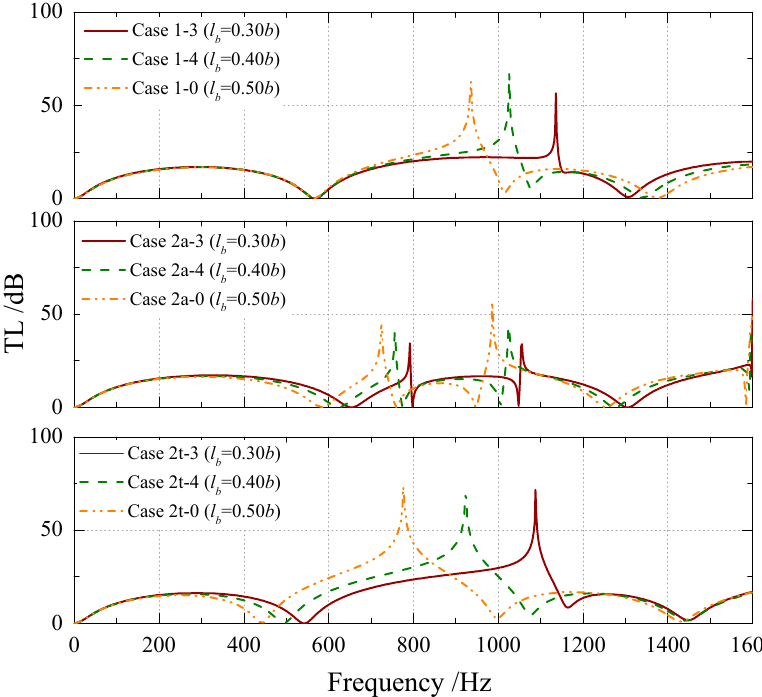
Figure 10. TLs of the RECs with different baffle lengths.